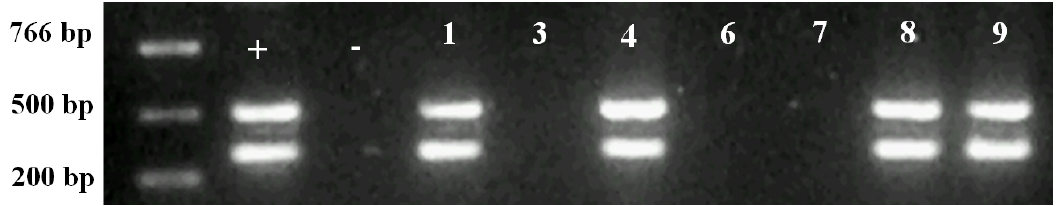
Figure 5. Co-segregation of the gusA and hpt transgenes in a PCR screen of line, 30-6. (+) positive control, plasmid DNA; ( − ) negative control, a representative T 1 wild-type O. sativa cv. Nipponbare DNA. Progeny plant identification numbers 1, 3, 4,